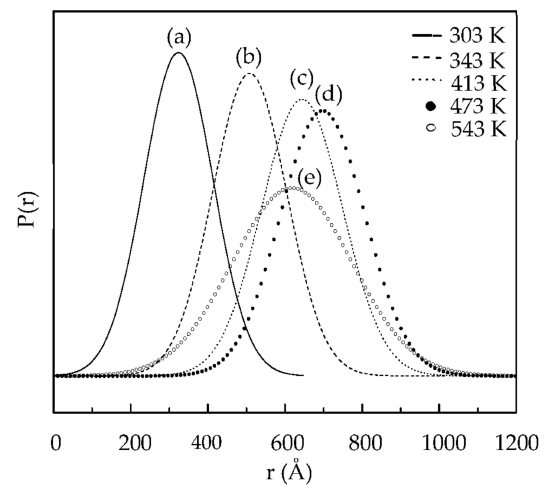
Figure 8. Particle size distributions of copper in the IL-I at ( a ) 303, ( b ) 343, ( c ) 413, ( d ) 473, and ( e ) 543 K with in situ SAXS fitting